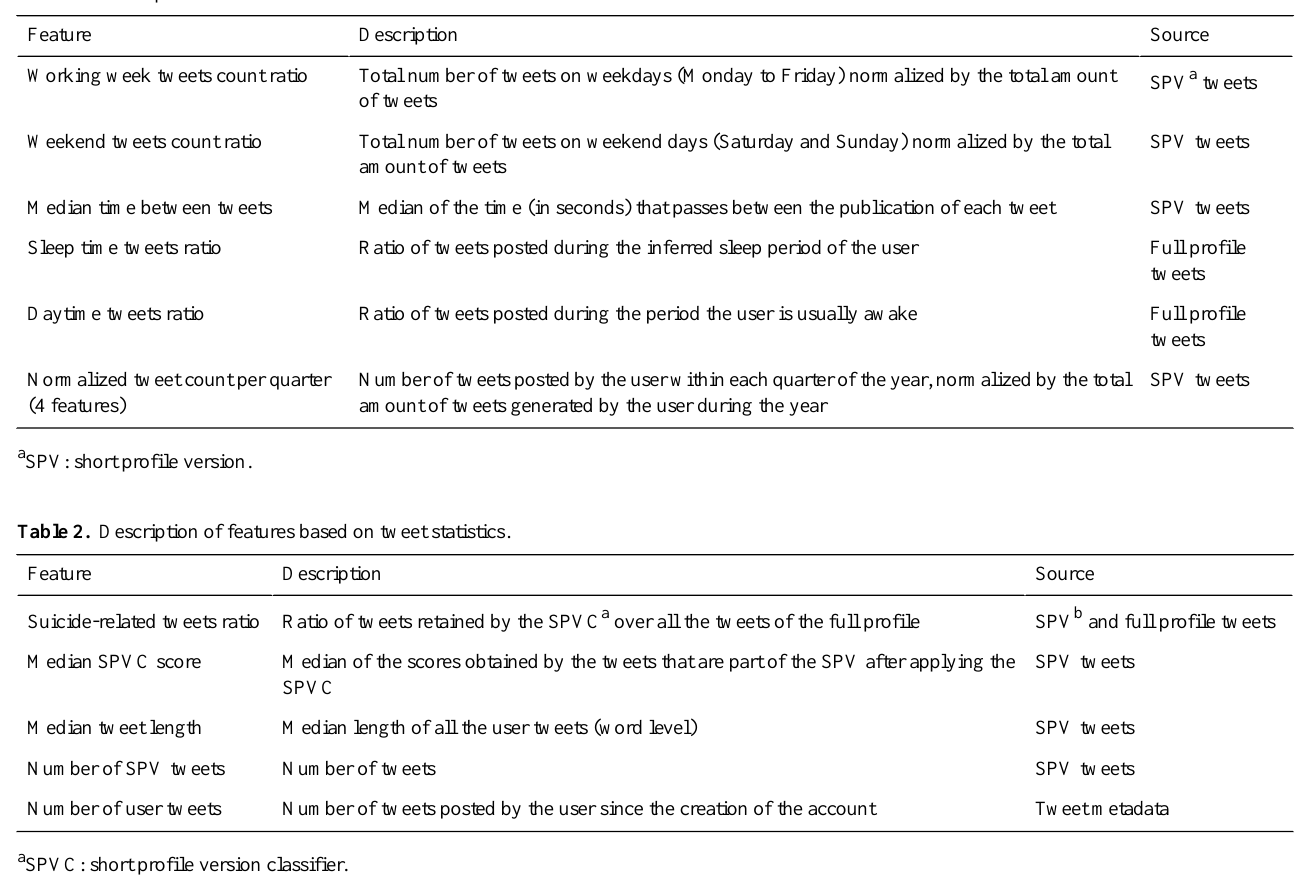
Table 1. Description of behavioral features.